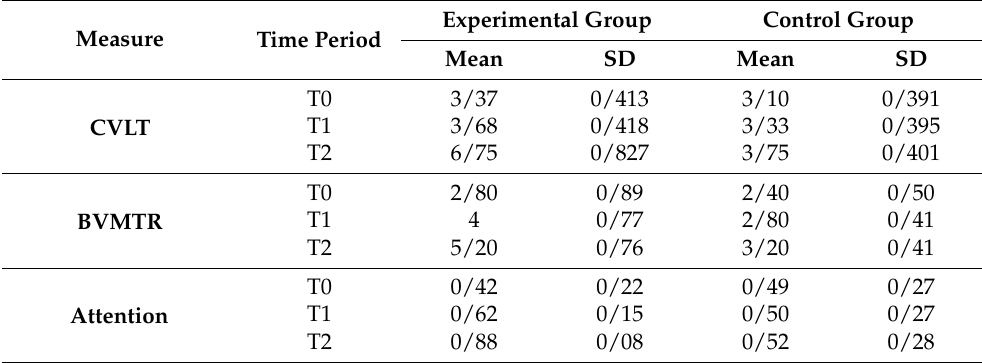
Table 2. Performance on neuropsychological measures for the ICRP group and control group at baseline, posttreatment, and at 3-month